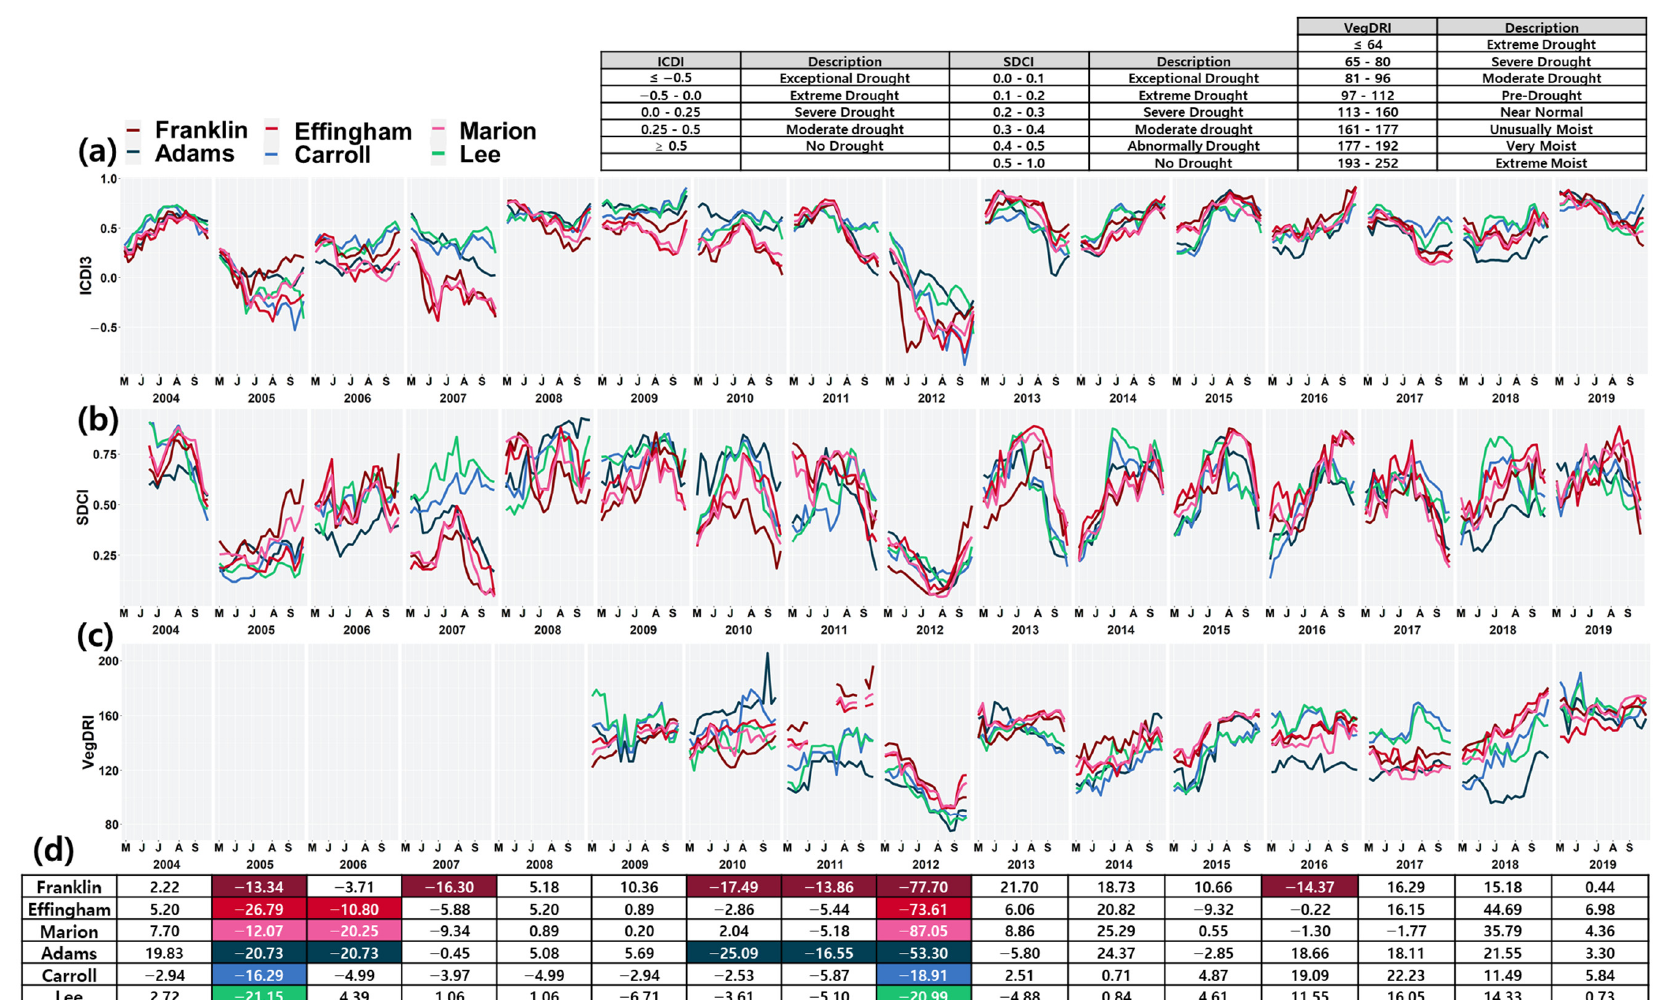
Figure 8. Time series of ( a ) ICDI3, ( b ) SDCI (Scaled Drought Condition Index), ( c ) VegDRI (Vegetation Drought Response Index), and ( d ) corn yield anomaly (%) in severely and moderately damaged counties during 2004-2019. The VegDRI data from USGS (United States Geological Survey) was provided from 2009 onward.